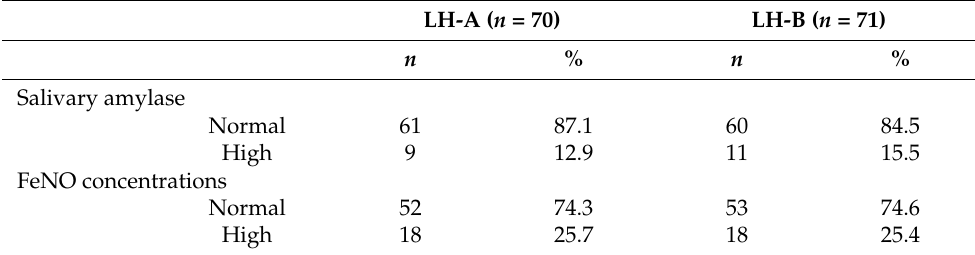
Table 1. Results of participants’ salivary amylase and FeNo concentrations stratified for LHs ( n = 141).